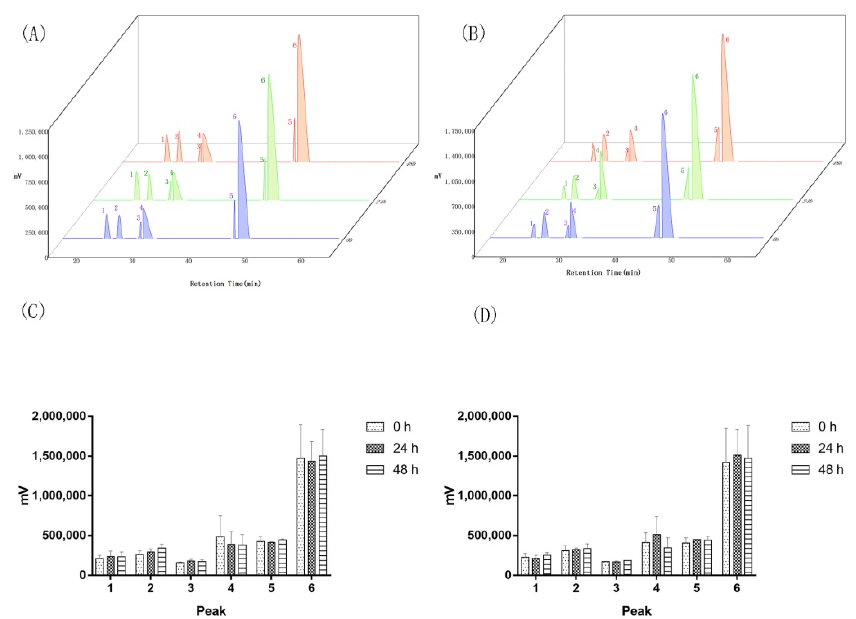
Figure A4. Phellodendron chinense Schneid powder fermentation ( A , C ): Bs-2 was added in Golden cypress powder and sterilized saline, and then the suspension was thoroughly mixed and incubated. Samples were taken at 0 h, 24 h, and 48 h and filtered for HPLC analysis. ( B , D ): Bs-4 was added in Golden cypress powder and sterilized saline, and then the suspension was thoroughly mixed and incubated. Samples were taken at 0 h, 24 h, and 48 h and filtered for HPLC analysis.